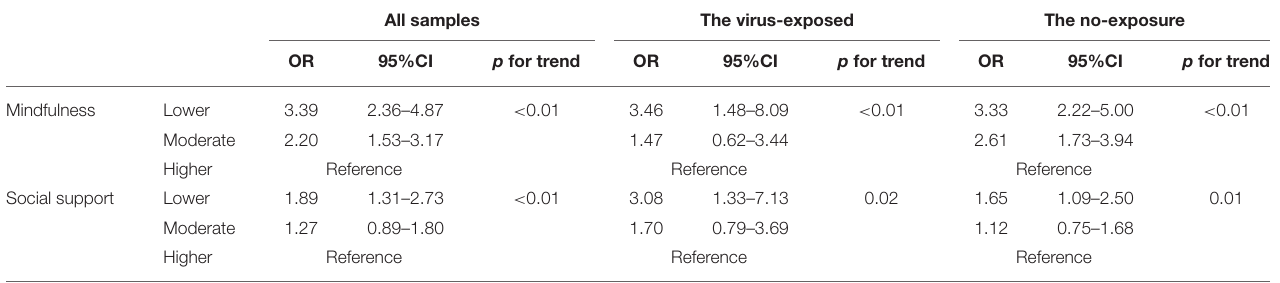
TABLE 3 | The association between odds of emotional exhaustion and the degree of mindfulness and social support among the participants and by exposure to SARS-CoV-2 using ordered logistic regression. All samples The virus-exposed The no-exposure OR 95%CI p for trend OR 95%CI p for trend OR 95%CI p for